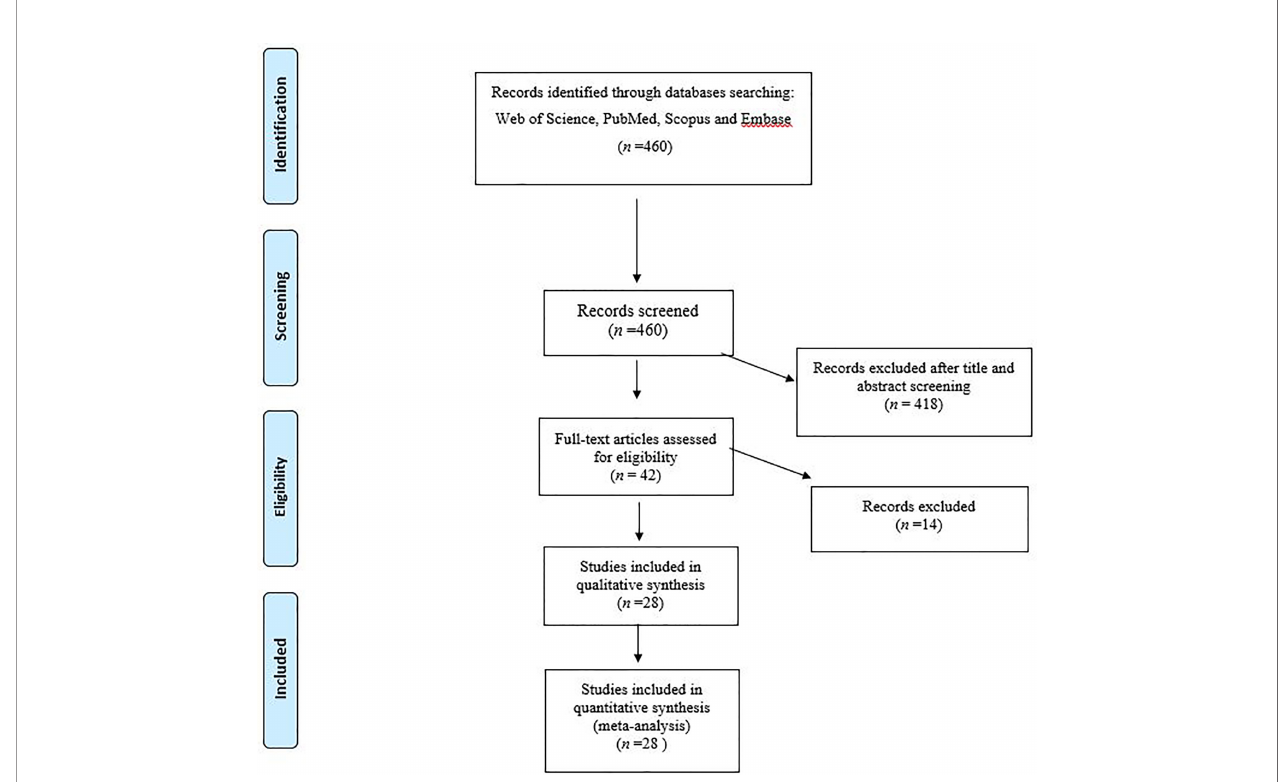
FIGURE 1 | Flow chart of the study selection for inclusion in the systematic